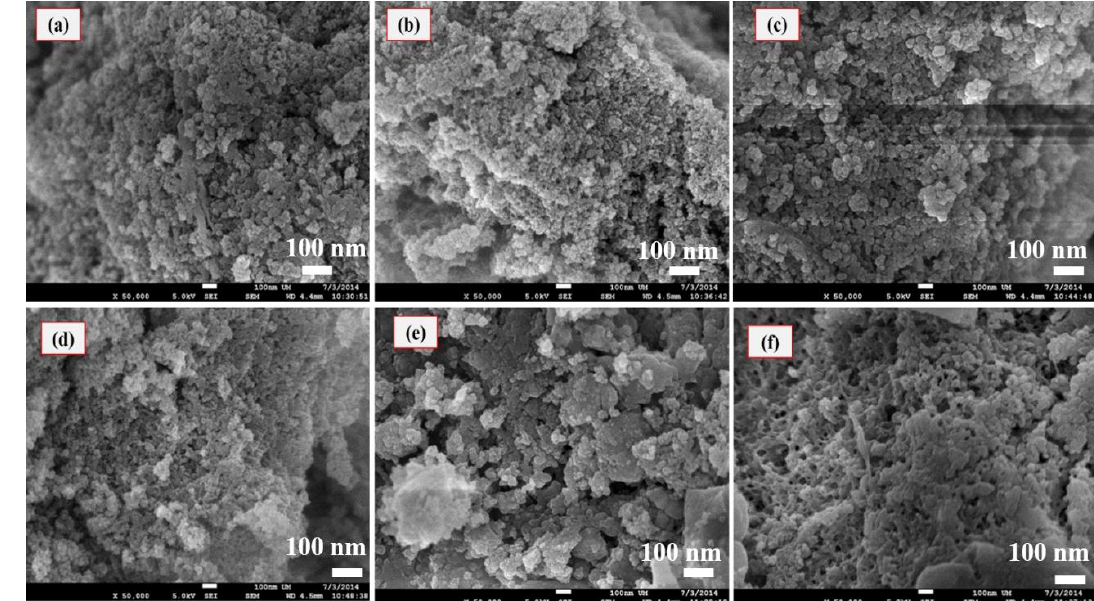
Figure 8. FESEM micrographs of PPVA-AlPO 4 nanocomposite samples formed from different pH of ( a ) 7; ( b ) 8; ( c ) 9; ( d ) 10; ( e ) 11; and ( f ) 12 at 50 k magnification.